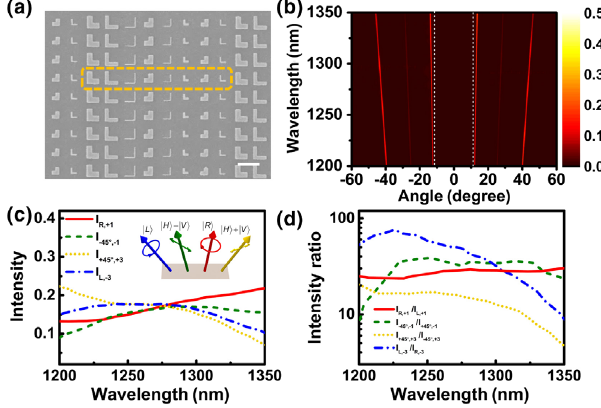
FIG. 5. (a) SEM micrograph of the fabricated metasurface as designed in Fig. 3(c). The unit cell is marked by the dashed-line box. The bar stands for 1 μ m. (b) Measured angle-resolved diffraction spectra. Four bright lines represent the diffracted beams measured at a different wavelength at different diffraction angles. The color bar stands for the intensity. (c) Normalized beam intensity of four diffracted beams. Here, I represents pol ; num the intensity of “ num-th ” order with “ pol ” polarization. Within the wavelength range of 1200 – 1325 nm, the normalized intensity of each diffracted beam is higher than 8%. At 1275 nm, the intensity of each diffraction beam is higher than 16%, and the total normalized intensity reaches 68%. (d) Measured light intensity ratio of each diffracted beam, which is defined as the intensity of the measured LP (CP) beam divided by the intensity of its orthogonal (conjugated) beam. The intensity ratio of each beam is larger than 10 for the wavelength between 1210 nm and 1300 nm, and the maximum reaches 76 at 1225